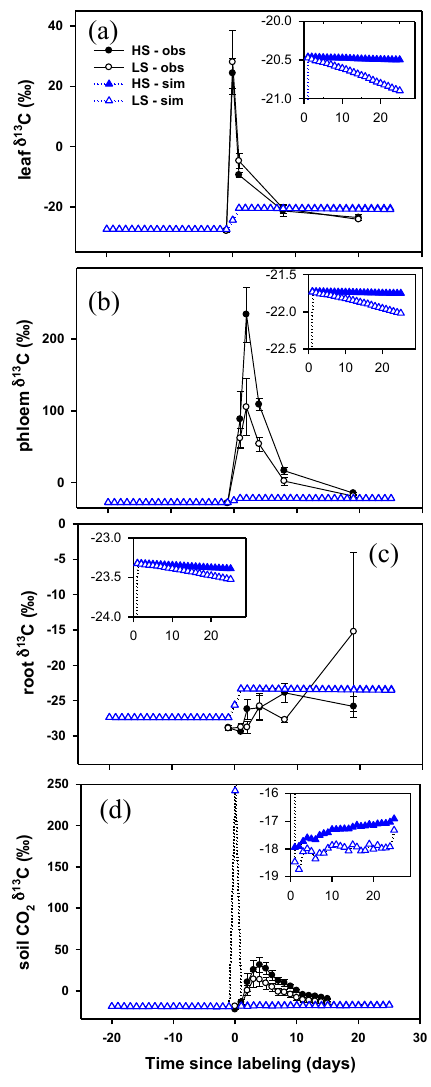
Figure 6. Observed (black) and CLM simulated (blue) change in δ 13 C (parts per thousand, ‰) of (a) leaf, (b) phloem, (c) bulk root, and (d) soil surface efflux δ 13 C for the light shade (LS, open circle) and heavy shade (HS, filled circle) pretreatment and treat- ment periods ( ± standard error). The modeled δ 13 C values were calculated from the CLM simulated 13 C and 12 C variables and the reference standard (0.0112372) using the equation described in https://en.wikipedia.org/wiki/ (cid:49) 13C. The 13 CO 2 labeling pulse was initiated on 1 September in year 2010 (day 0). To better visualize the model results, inset figures illustrate the CLM simulated δ 13 C values for the light shade (open triangle) and heavy shade (filled triangle) treatments from day 1 to day